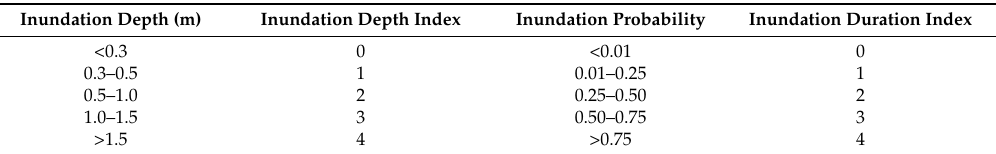
Table 1. Inundation depth and inundation duration index.